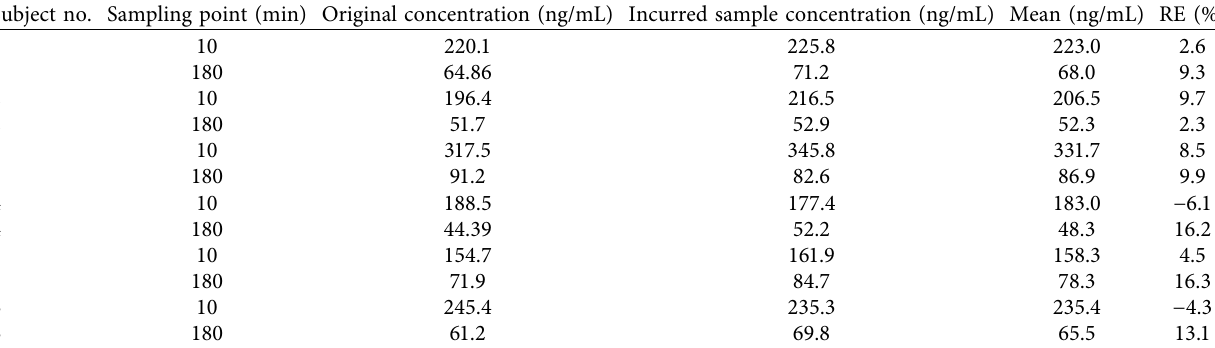
Table 4: Incurred sample reanalysis data of liquiritin.